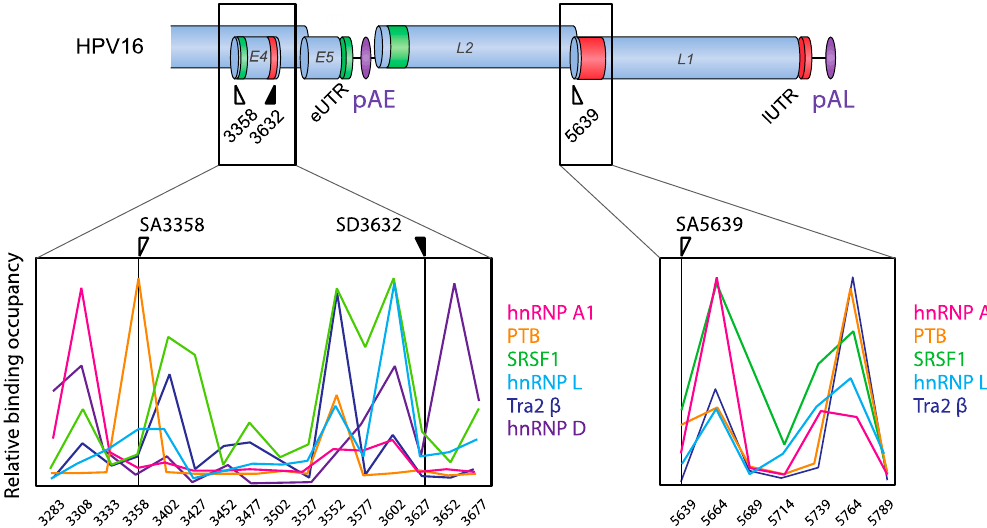
Figure 6. Hot spots for RNA-binding proteins (RBPs) at HPV16 splice sites SA3358, SD3632, and SA5639. Extensive mapping of protein interactions with HPV16 RNAs revealed the existence of hot spots for RNA-binding proteins (RBPs) on HPV16 mRNAs. These “RBP hot spots” were centered around HPV16 splice sites SA3358, SD3632, and SAA5639. Quantitations of the RNA–protein interactions and determination of relative binding occupancy of various RBPs (hnRNP A1, PTB, SRSF1, hnRNP L, Tra2B, and hnRNP D) at these hot spots are shown. The results shown here are adapted from [48].